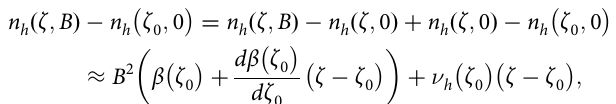
is valid at B < F h for any dispersion of these charge carriers,